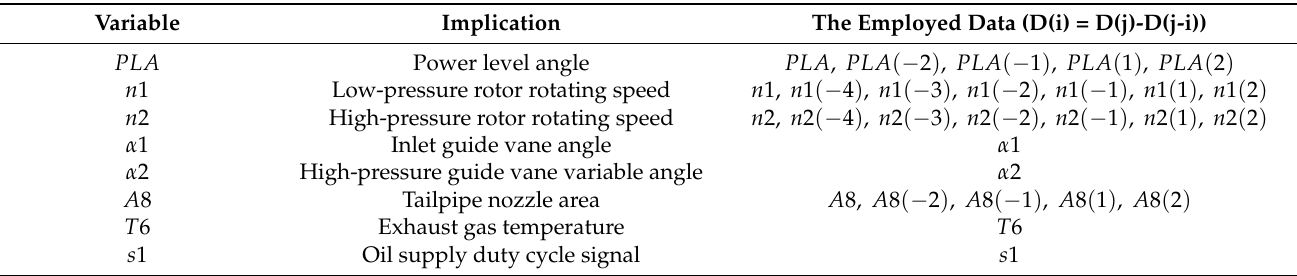
Table 1. Input signals used in the